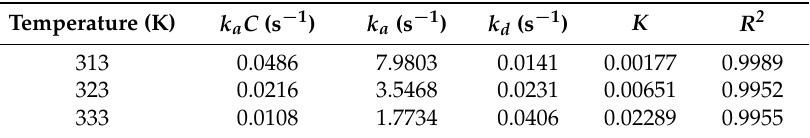
Table 3. Thermal desorption parameters and model errors.